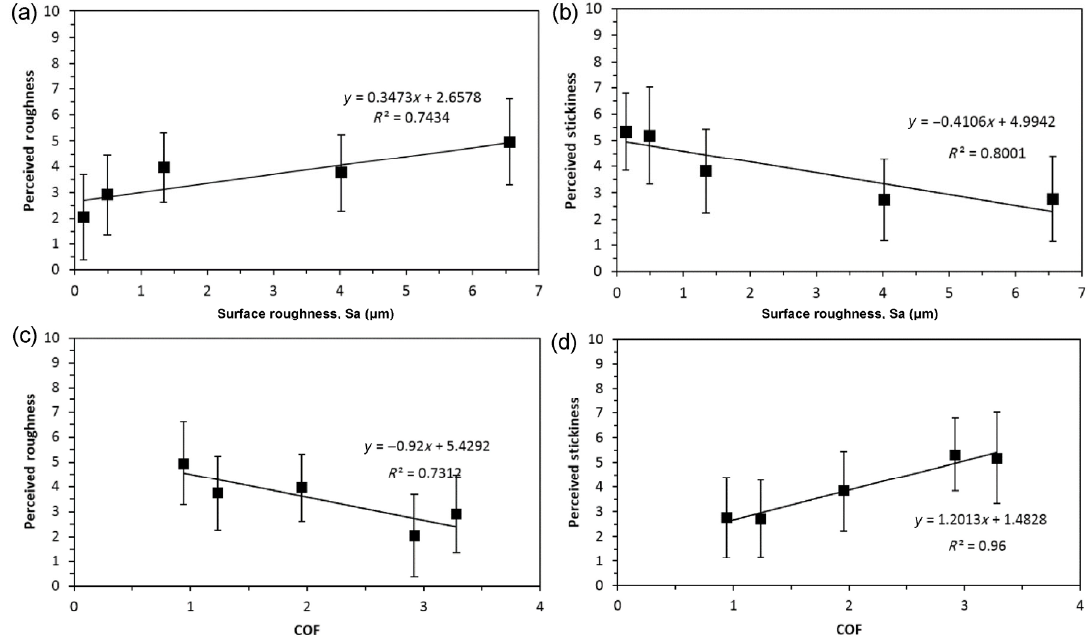
Fig. 9 Geometric mean of perceived roughness versus (a) 3D surface roughness Sa, and (c) COF; and geometric mean of perceived stickiness versus (b) surface roughness Sa, and (d)